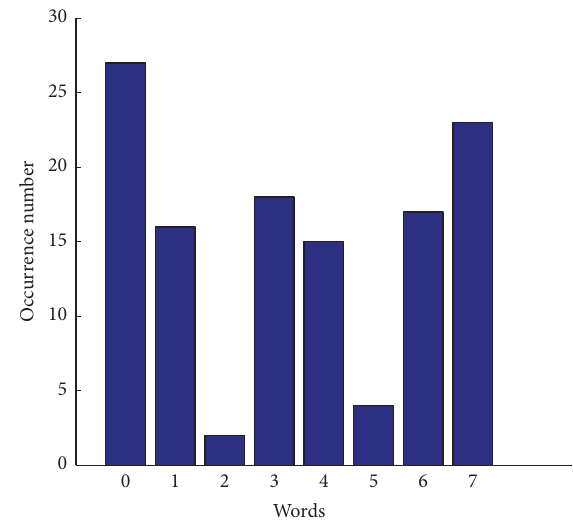
Figure 2: Histogram of symbol sequence word.